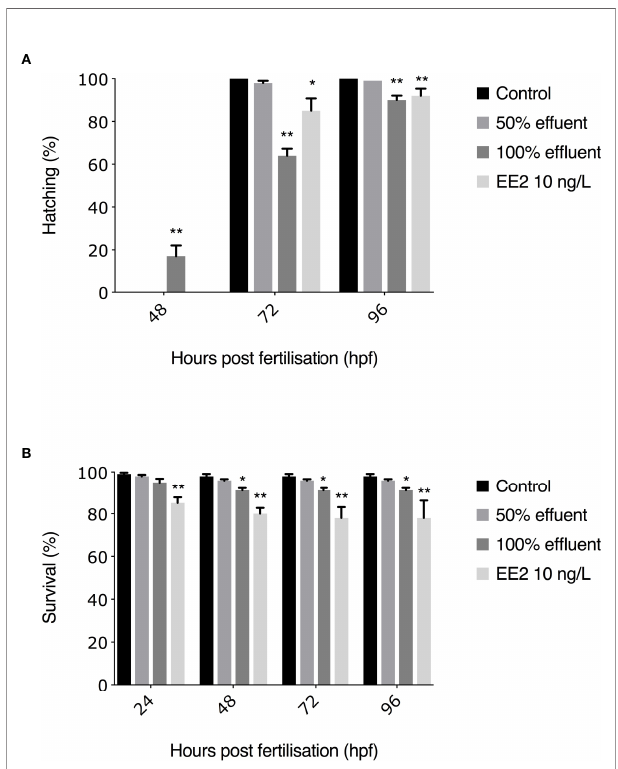
FIGURE 2 | Hatching rates (A) and subsequent survival (B) to 96 hpf of ERE-GFP Casper zebra fi sh. Transgenic zebra fi sh embryos were exposed to EE2 (10 ng/L), a WwTW ef fl uent concentration (50% or 100%) or dilution water control. Data are reported as mean ± SE. Asterisks denote a signi fi cant difference (*p ≤ 0.05, **p ≤ 0.01) compared with control.